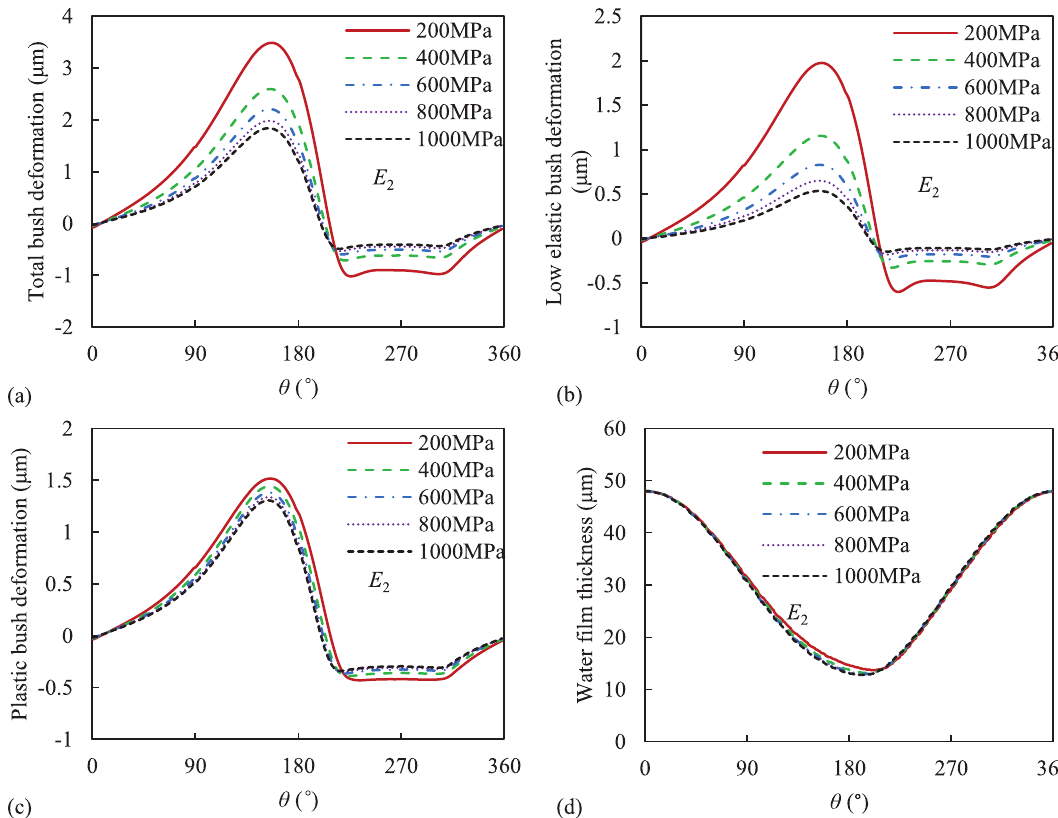
Fig. 12. (a) Bush total deformation distribution, (b) Deformation distribution of low elastic under-layer bush, (c) Deformation distribution of plastic layer bush, (d) Water fi lm thickness distribution for different low elastic under-layer bush elastic modulus ( e =0.6, N =1500 rpm, t 1 = t 2 = 5mm, E 1 = 1000MPa, n 1 =0.4, n 2